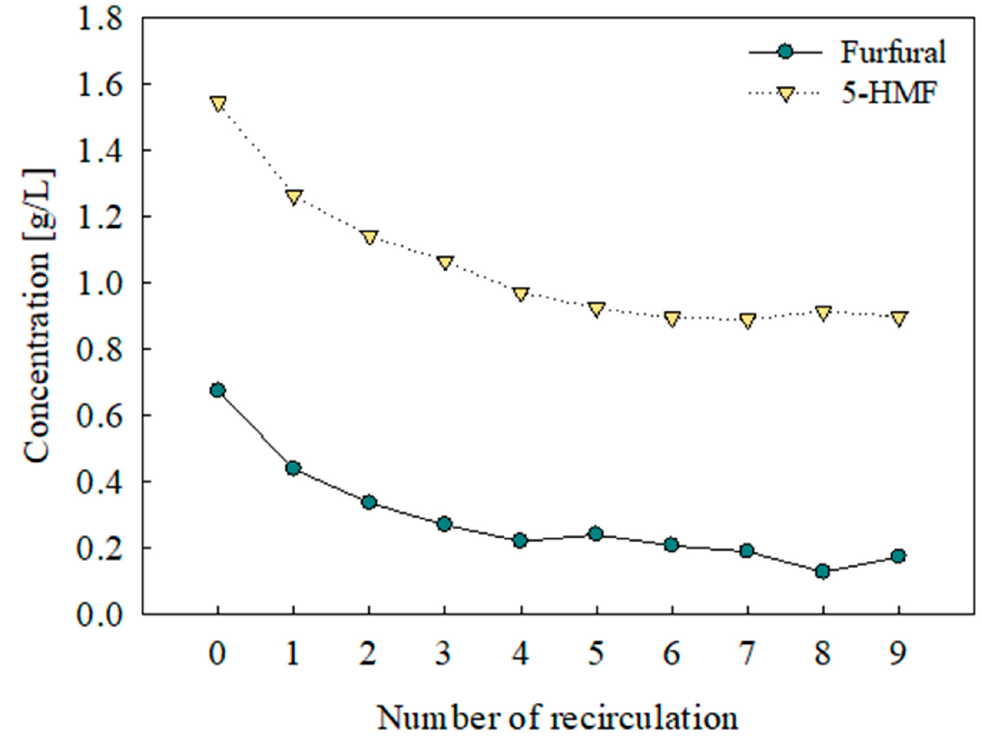
Figure 2. Concentration of intermediate products in bioliquid